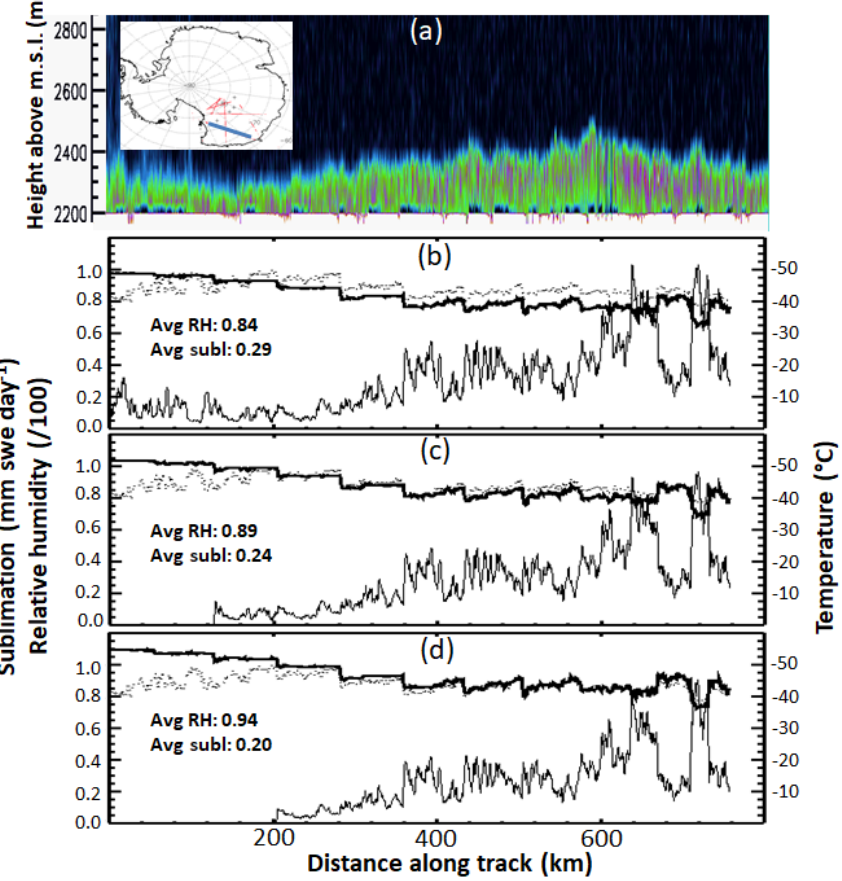
Figure 9. (a) CALIPSO backscatter showing blowing snow layer along the blue line in the map inset on 10 December 2010 at 05:51UTC. (b) Average MERRA-2 moisture (dark black line), temperature (dotted line) and calculated sublimation through the blowing snow layer along the CALIPSO track. (c, d) Same as in panel (b) but increasing MERRA-2 humidity by 5 and 10%,